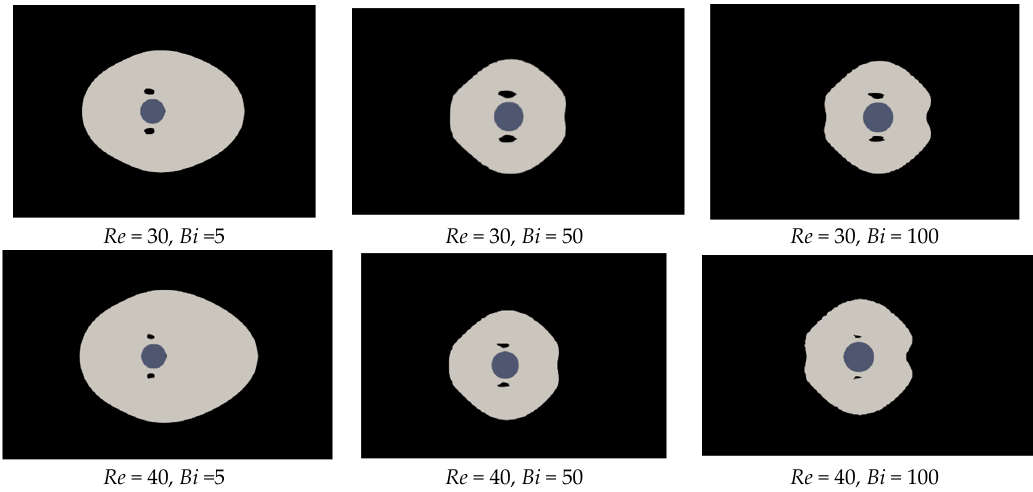
Figure 5. Simulation results to show the progressive growth of the unyielded region (shaded).